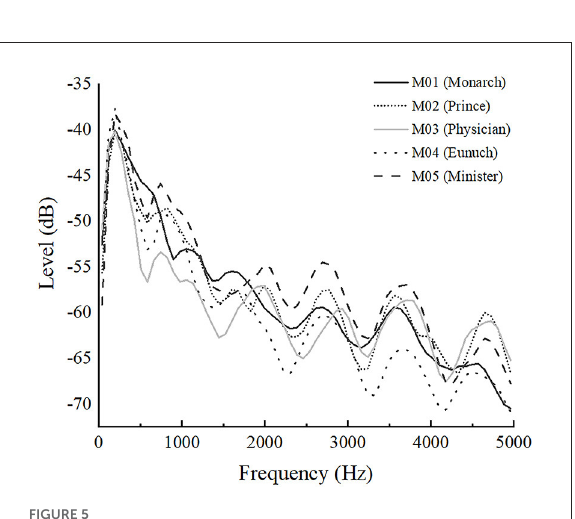
FIGURE5 LTAS of the five